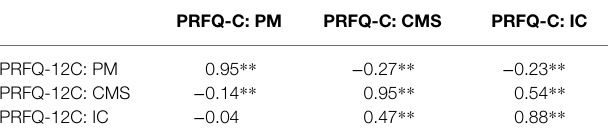
TABLE 4 | Intercorrelations between the PRFQ-12C and the